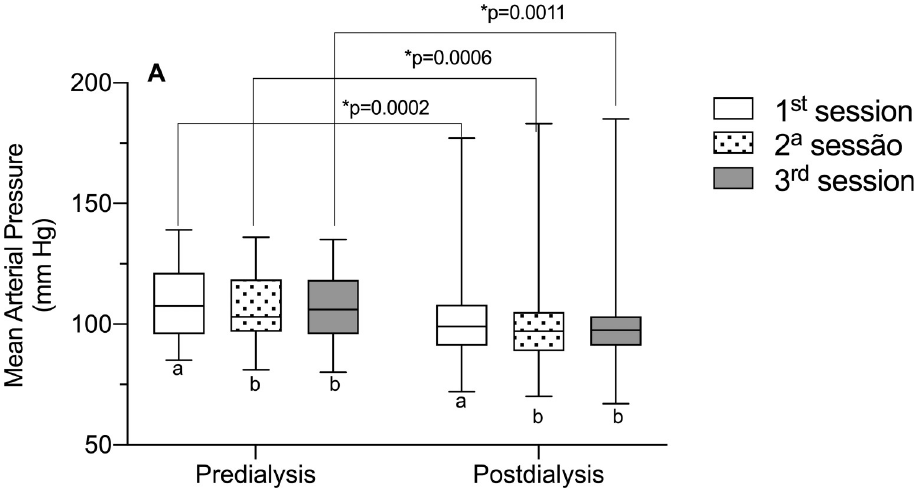
Fig 4. Mean arterial pressure in the different hemodialysis sessions of the week. Significant statistical differences were observed for the mean arterial pressure (MAP) parameter when comparing it with the different hemodialysis sessions of the week (1 st , 2 nd , and 3 rd ). Different letters, significant differences between the different sessions in the pre- and post-dialysis moments (p < 0.05, ANOVA for repeated measures and Tukey’s post-test).